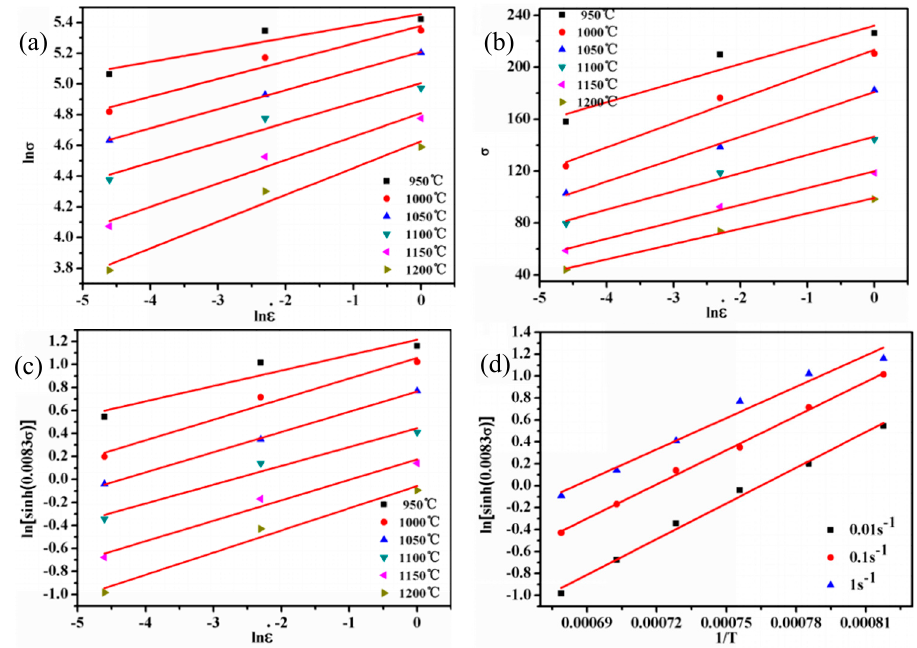
. . . ε , ( b ) σ − ln ε , ( c ) ln [ sinh ( ασ )] − ln ε , ( d ) ln [ sinh ( ασ )] − 1/T.